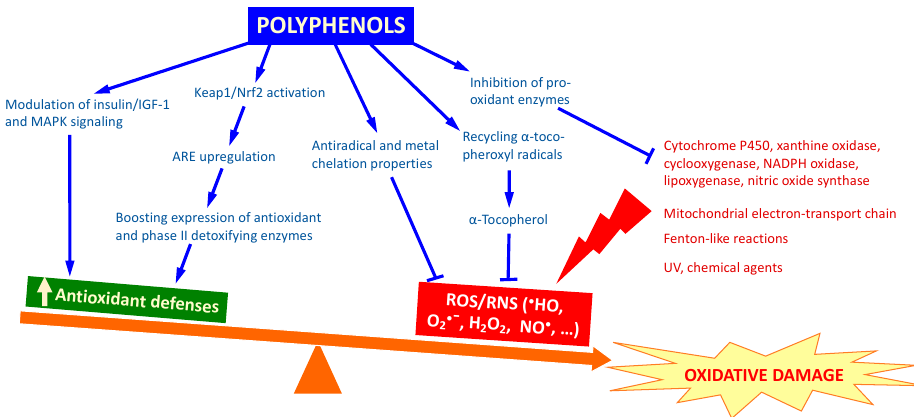
Figure 1. Induction of oxidative damage and its modulation by polyphenols.